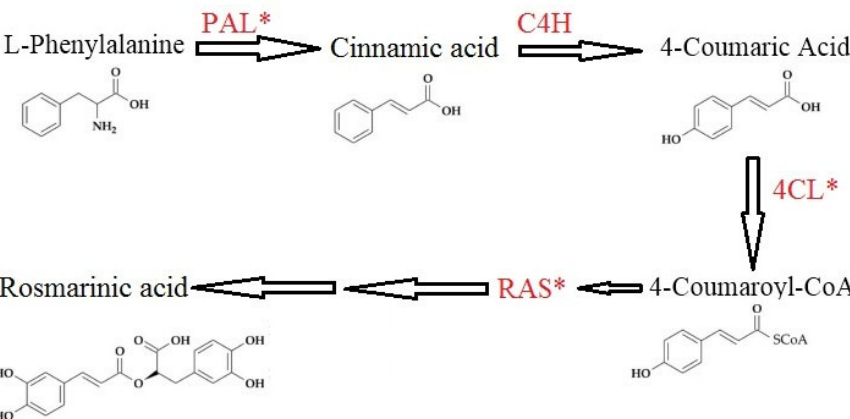
Figure 1. The biosynthesis of rosmarinic acid. The enzyme genes for phenylalanine ammonia lyase ( PAL ), 4-coumarate-CoA ligase ( 4CL ), and rosmarinic acid synthase ( RAS ), among others, are marked with an asterisk.